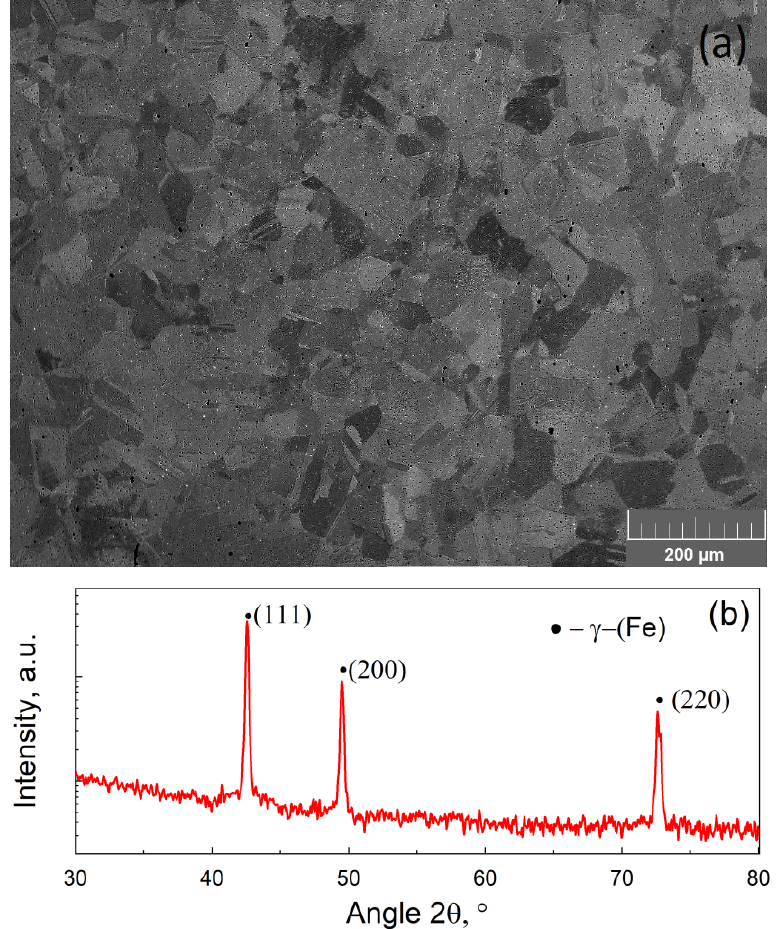
Figure 3. Grain microstructure and phase composition of the Fe – 28Mn – 8Al – 1C steel before deformation: SEM ( a ) and XRD pattern ( b ).